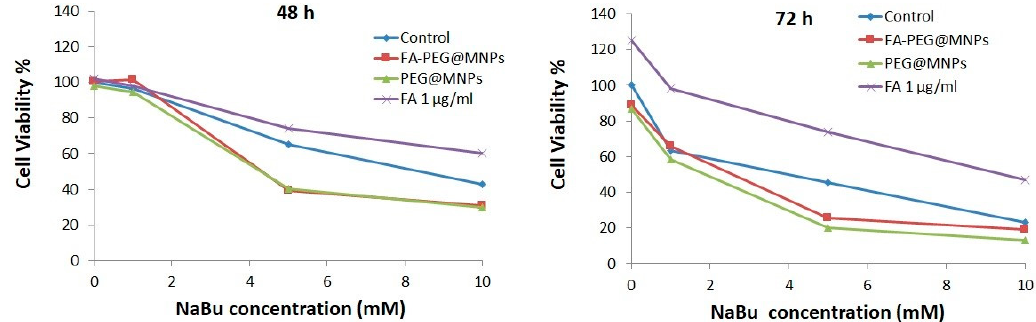
Figure 1. Viability of LoVo cells (MTT assay) incubated for 48 h and 72 h with various NaBu concentrations in the absence (blue line) and the presence of FA (violet line), FA-PEG@MNPs (red line) and PEG@MNPs (green line).